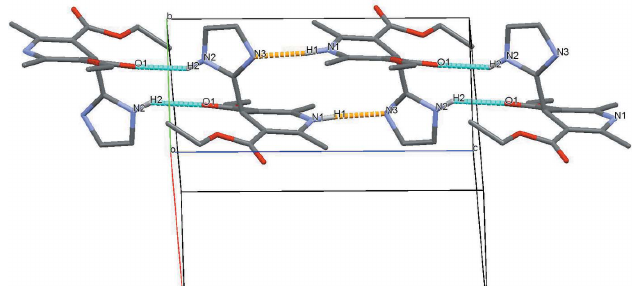
Figure 2 Part of the crystal structure with two intermolecular hydrogen bonds (blue and yellow dashed lines) are shown. For clarity, only those H atoms involved in hydrogen bonding are shown.